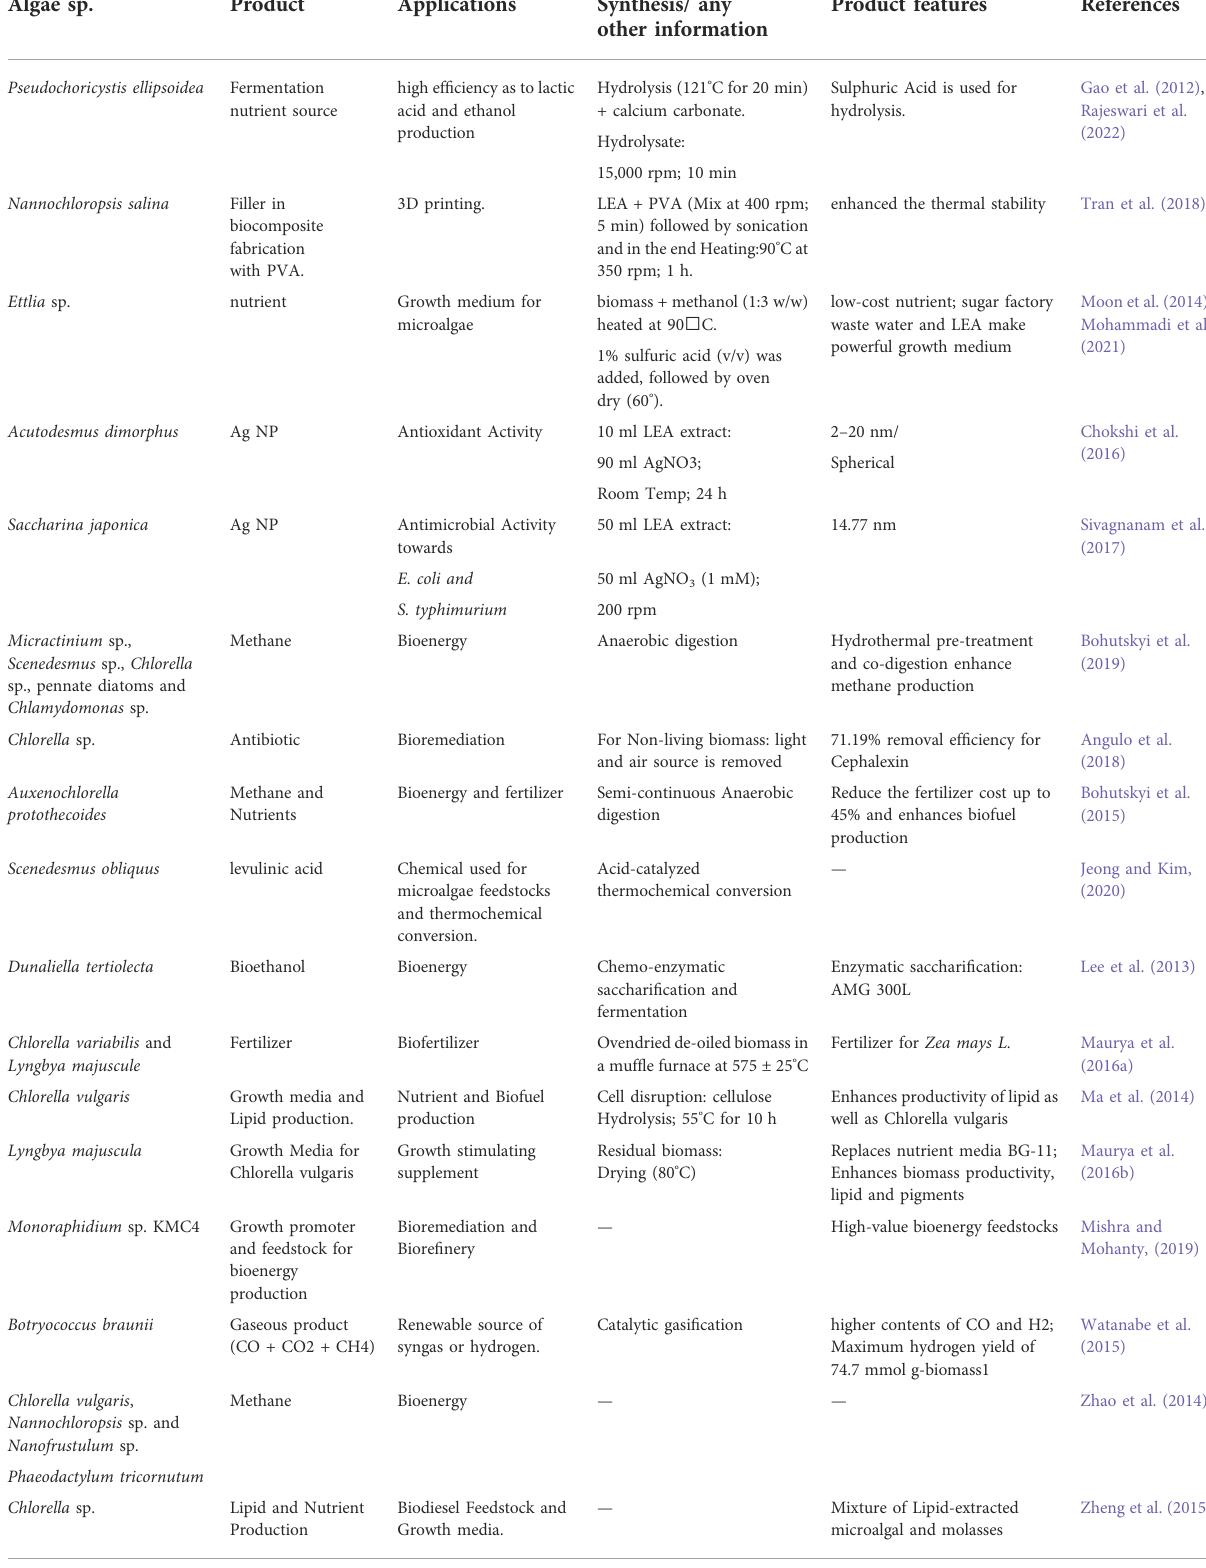
TABLE 4 Biore fi nery based algal products. Algae